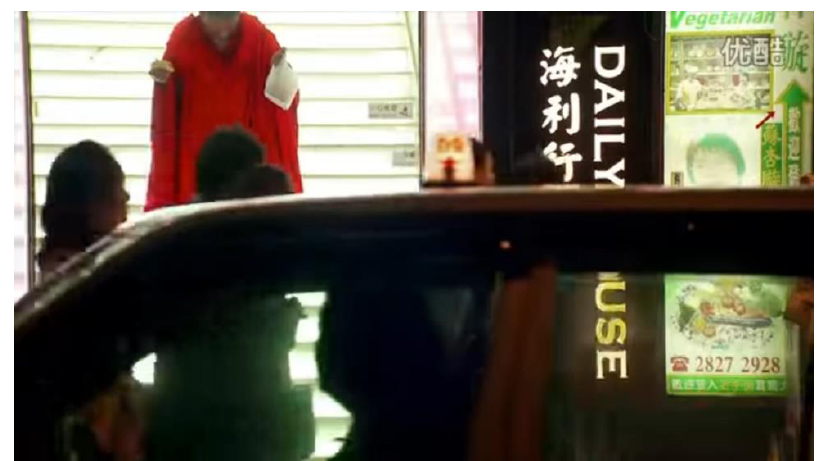
Figure 3. Transitory traffic, intransient walker.